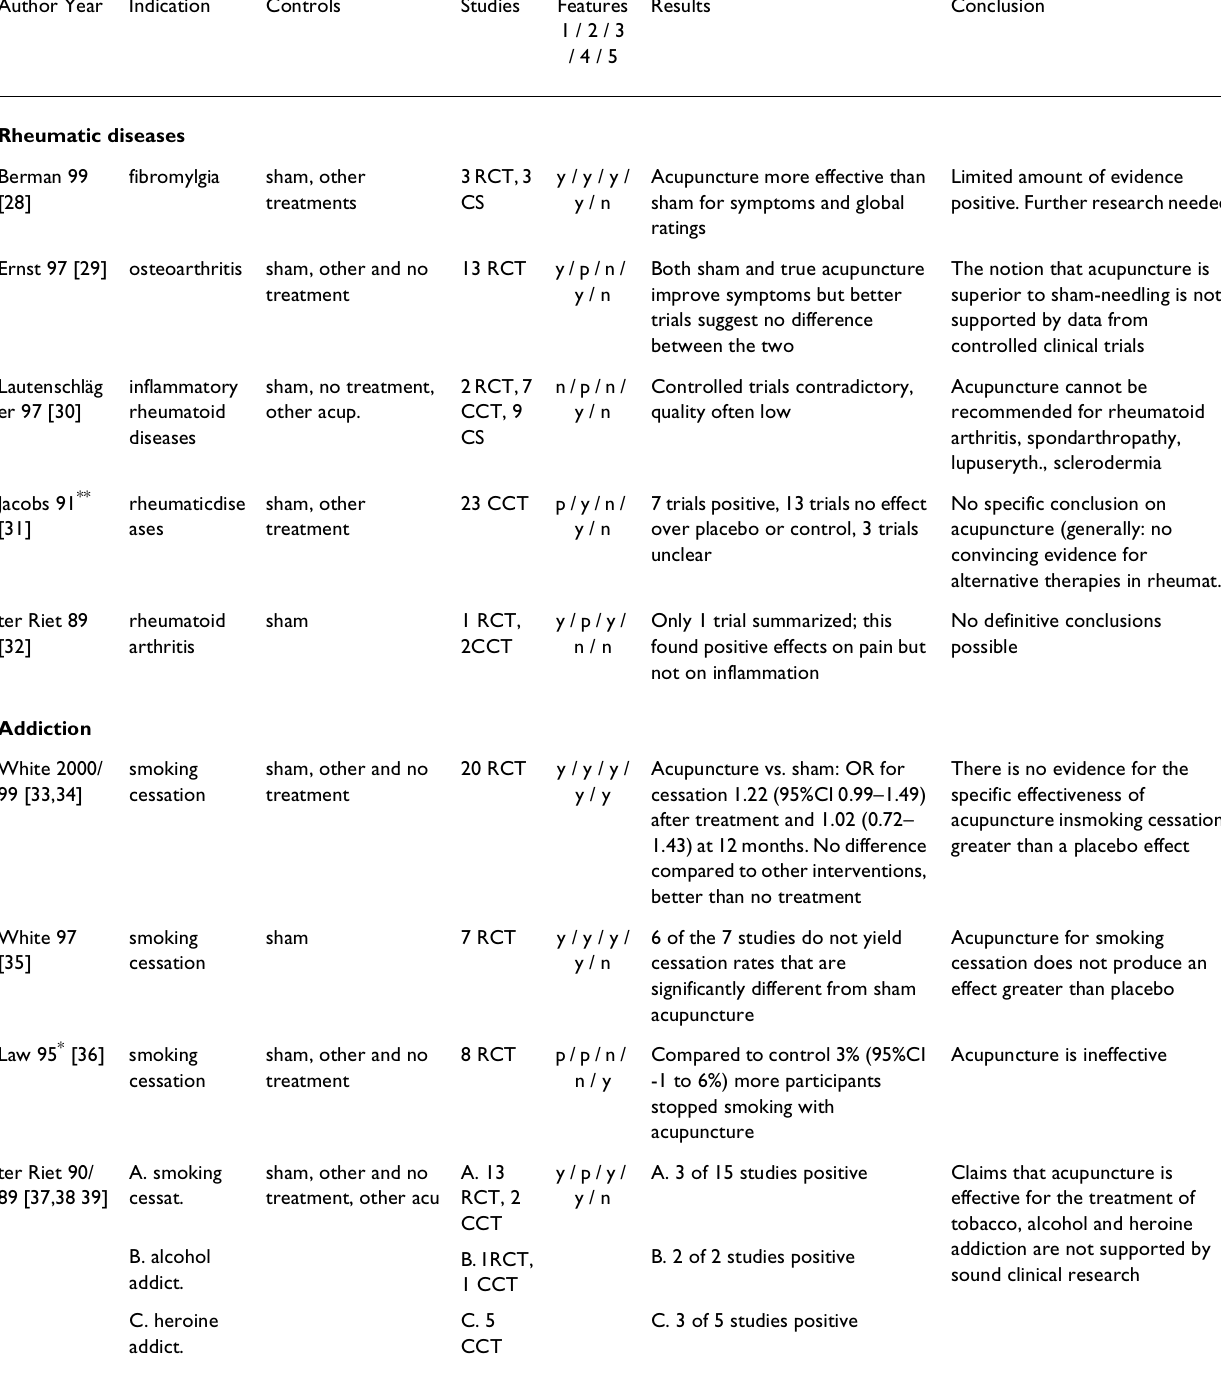
Table 2: Systematic reviews of clinical trials of acupuncture & acupressure in rheumatic diseases, addiction, nausea and asthma Author